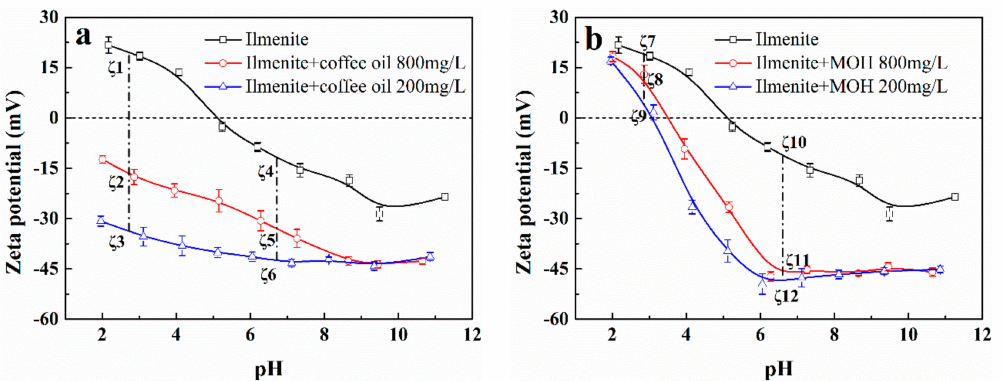
Figure 4. Zeta potentials of the ilmenite surface before and after adsorption with di ff erent collectors as a function of pH: ( a ) co ff ee oil, ( b )